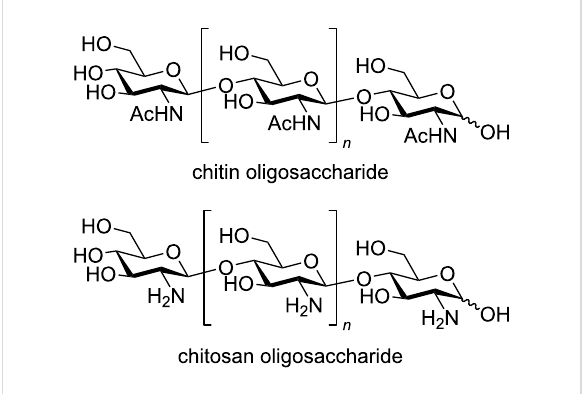
Figure 1: Structures of chitin and chitosan oligosaccharides.